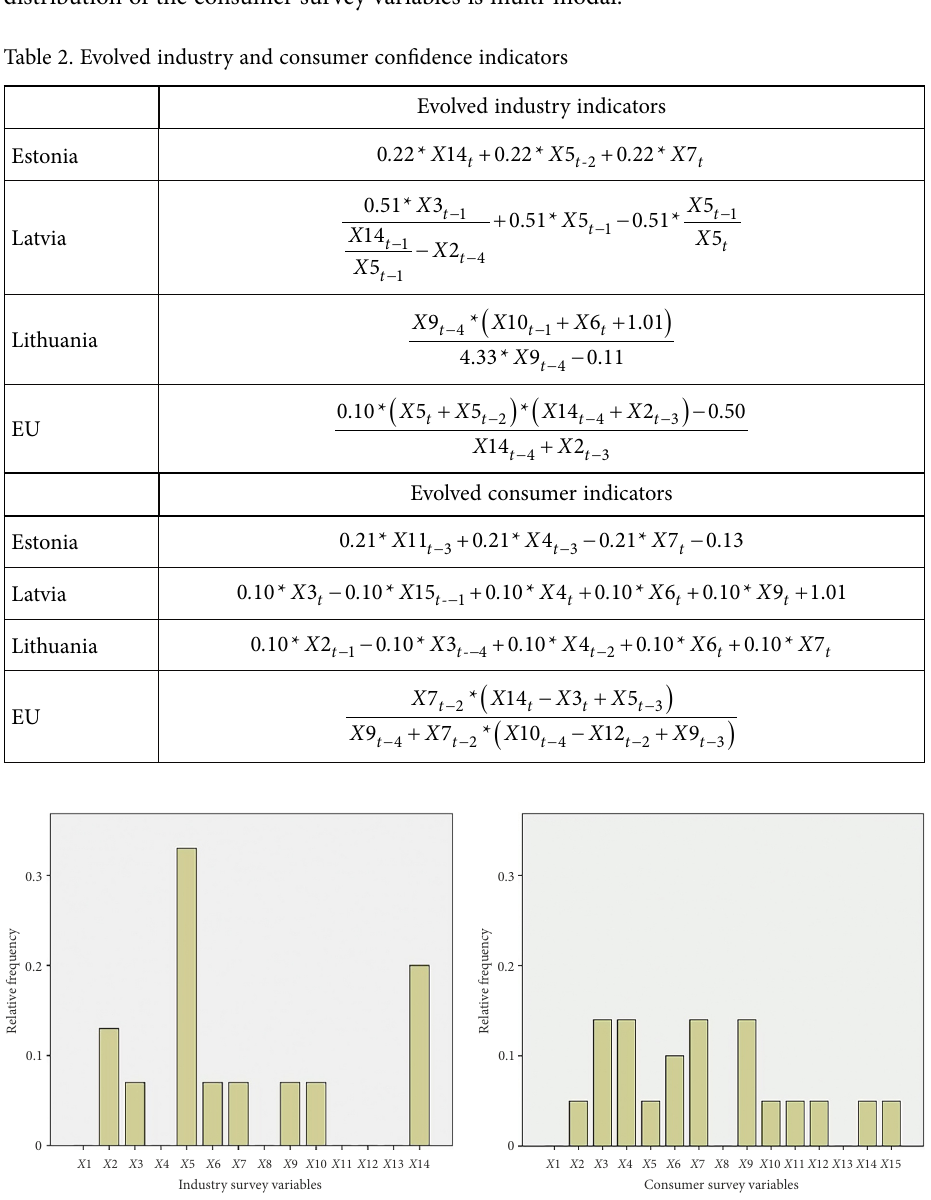
Consumer survey variables